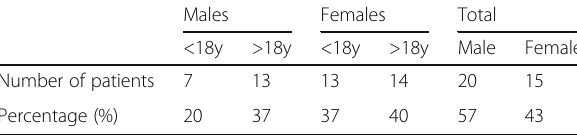
Table 1 Age and sex distribution among patients